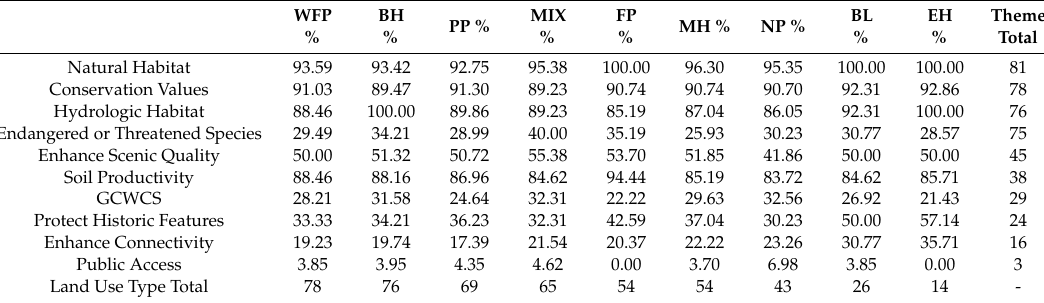
Table 2. Cross-tabulation of easement themes by land use types based on 86 WFCEs in